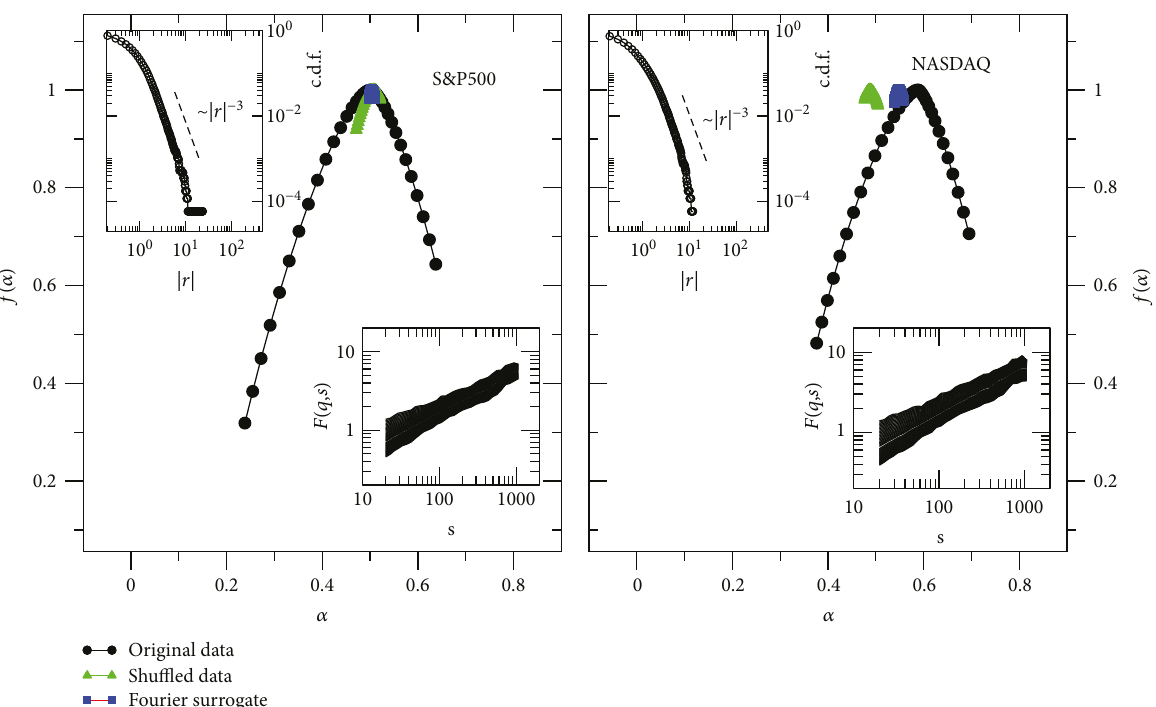
Figure 1: Main panels: multifractal spectra calculated for the S&P500 and NASDAQ returns (black dots) covering the period January 03, 1950 – December 29, 2016. Average spectra obtained for the Fourier phase-randomized surrogates and for the randomly shu ffl ed time series are denoted by blue squares and green triangles, respectively. Upper-left insets display cumulative distributions of return fl uctuations, and lower-right insets display the fl uctuation functions calculated for the original S&P500 and NASDAQ